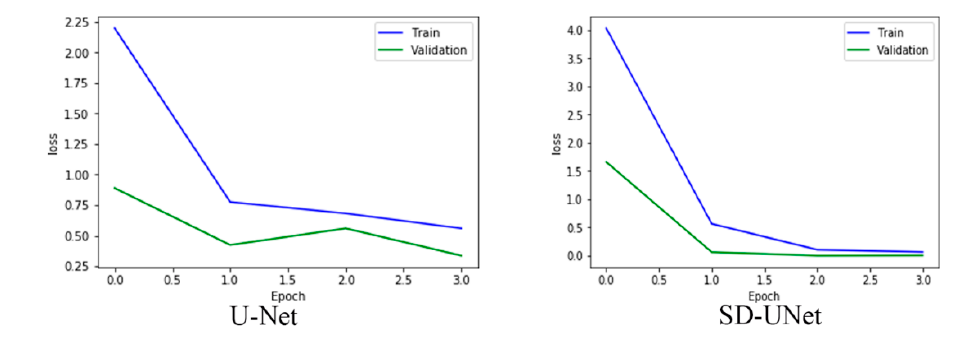
Figure 10. SD-UNet shows a faster convergence and improved loss during training.